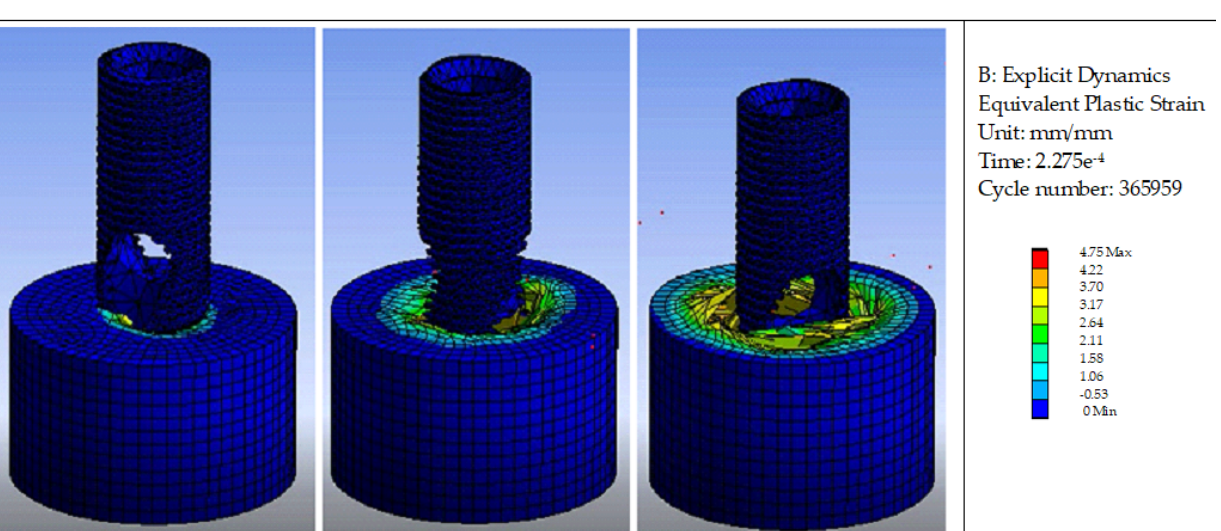
Figure 3. Numerical results at the end time of the simulation.